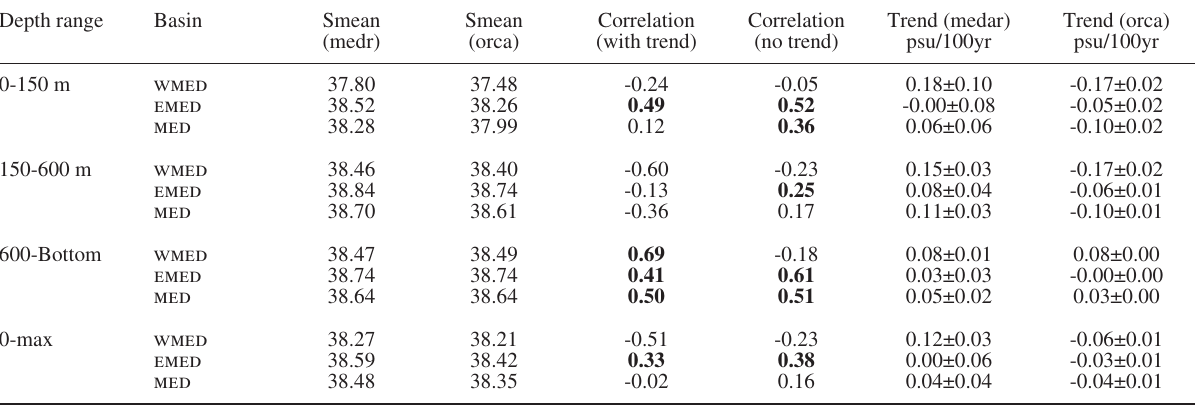
Table 2. – ORCA and MEDAR salinity statistics related to Figure 2. Correlation values that are significant to 99% are in bold.